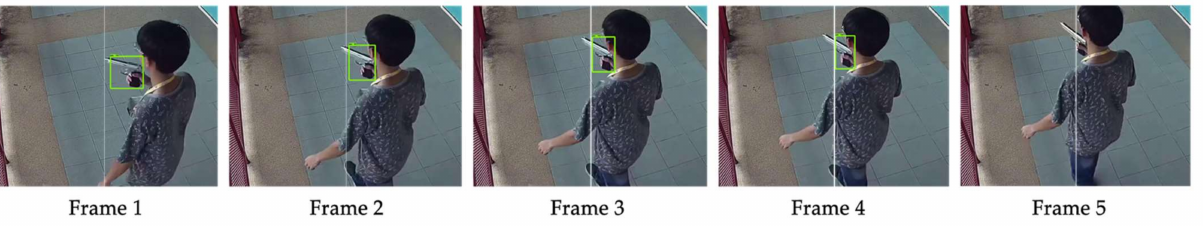
Figure A2. Weapon detection results on sequence images using the Tiling ACF Dataset on the SSD MobileNet V2